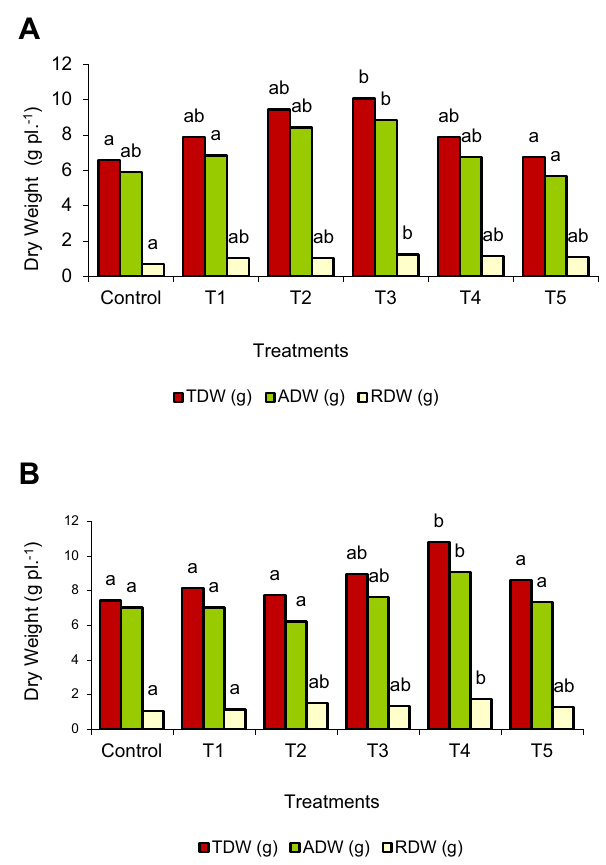
Fig. 4 Effect of different compost and mineral fertilizer dosages over the dry weight of lettuce harvested in experimental plots. a First year, b second year. TFW total fresh weight, AFW aerial fresh weight,